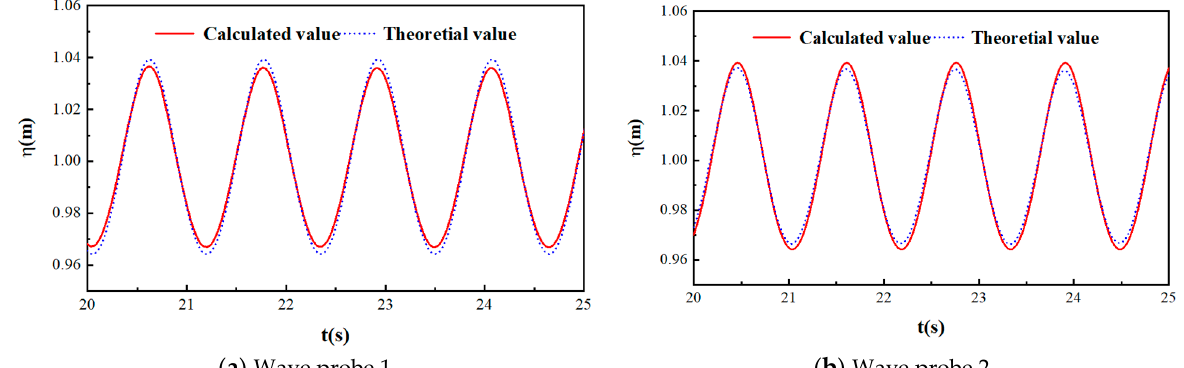
Figure 5. Comparison of calculated and theoretical values.